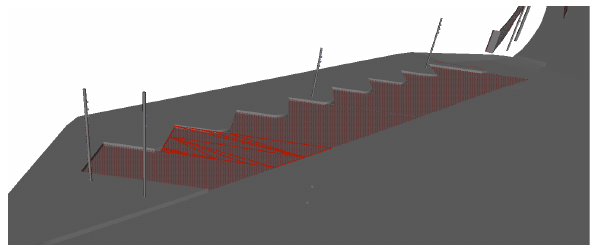
Figure 12. Downward oriented parking lots due to clockwise ordering of outline elements in the linear reference system.